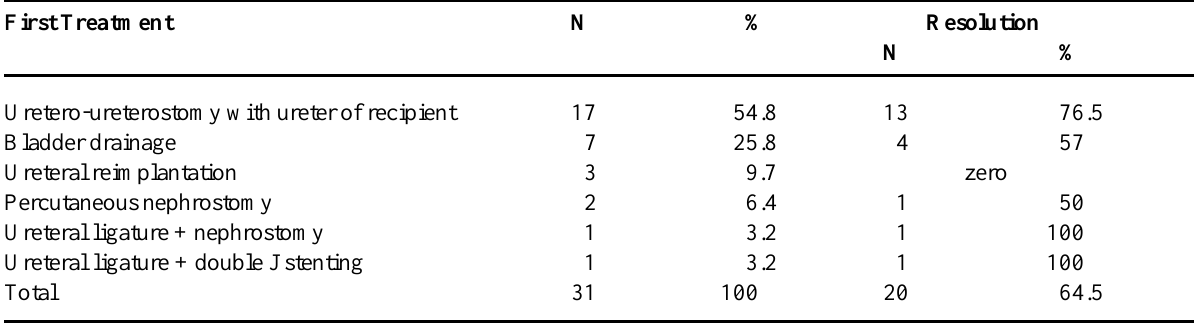
Table 2 – Treatment employed in urinary